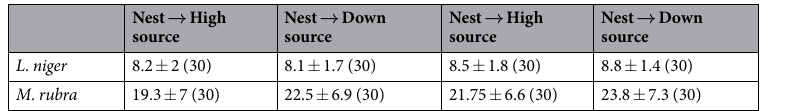
Table 3. Travel speed on the ascendant and descendant branches. The time (in sec) required to cross a branch was measured in the DH condition. Time needed to cross a branch was measured between points (2) and (3) for the ascending branch and between (4) and (5) for the descending one (see 4).